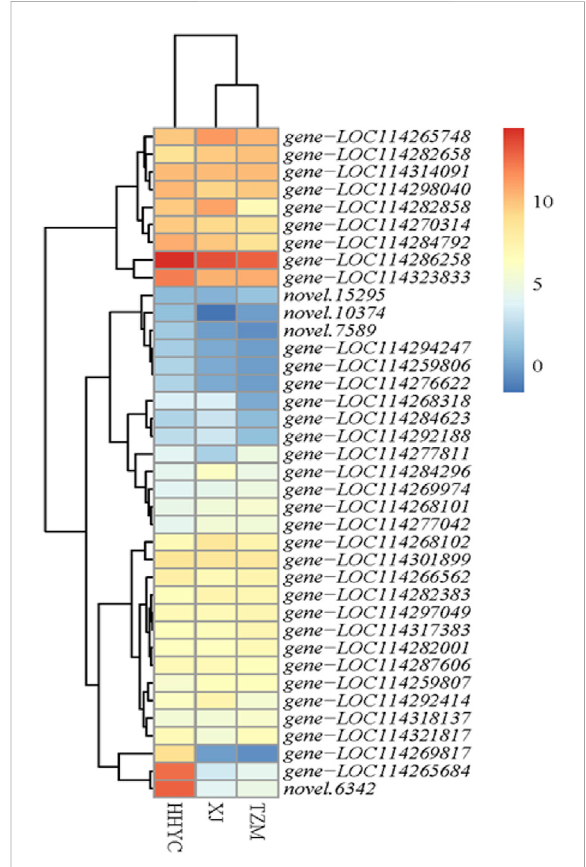
FIGURE 4 Heatmap clustering of thirty-eight structural genes involved in carotenoid biosynthesis among the three contrasting fl owers of C. reticulata (HHYC), C. reticulata ‘ Xuejiao ’ (XJ) and C. reticulata ‘ Tongzimian ’ (TZM). The expression levels of the genes were log2 transformed from averages of the three biological repeats from each genotype and the transformed data were used to draw theheatmap.Color diagramat therightside shows theintensity of the gene